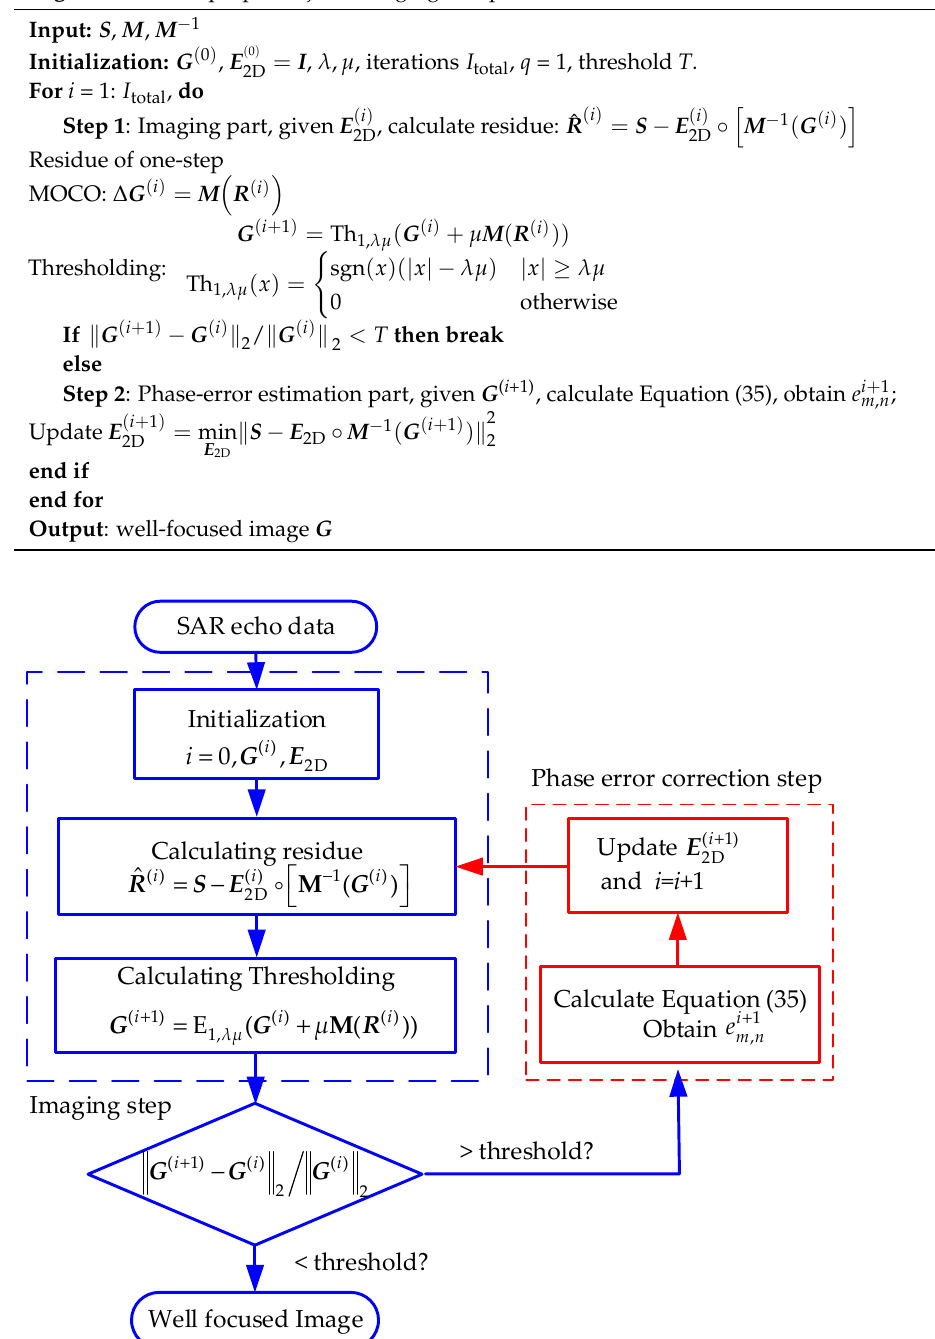
Algorithm 1. The proposed joint imaging and phase-error correction method.